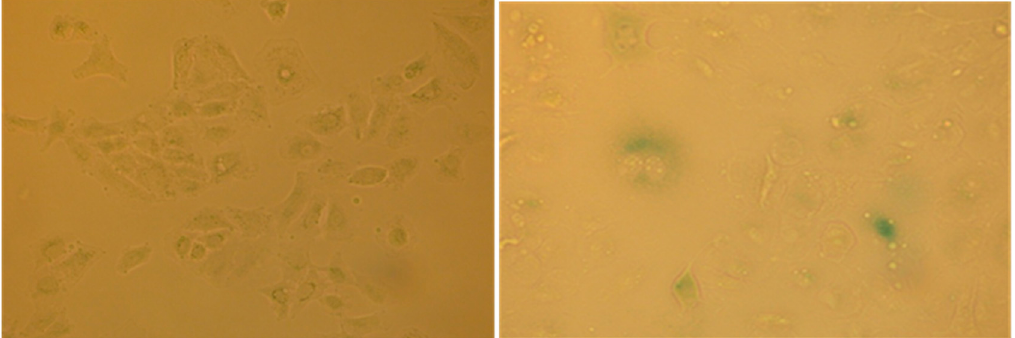
Figure 12. β -Galactosidase activity in senescent A549 cells: ( left ) negative control at pH 6; and ( right ) cells treated with extract #57 and then analyzed 72 h later, as described in the text.